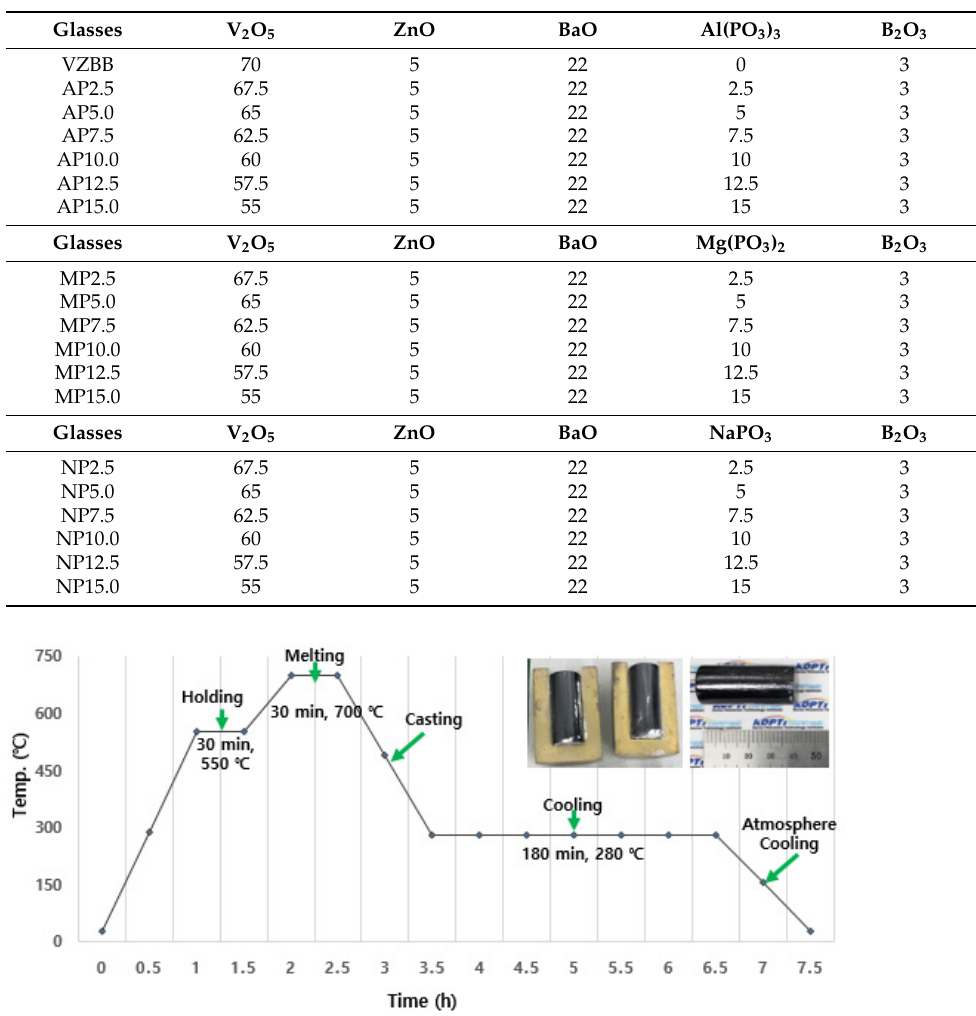
Table 1. Chemical composition of the present glasses, (Al(PO 3 ) 3 = xAP, Mg(PO 3 ) 2 = xMP and NaPO 3 = xNP (where x = 2.5, 5, 7.5, 10, 12.5, 15) (mol%).